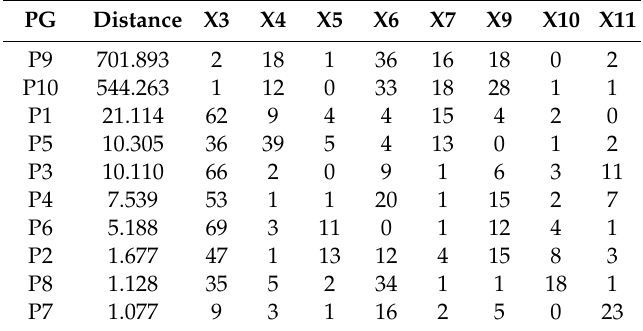
Table 13. Analysis of the root cause by contribution ratios